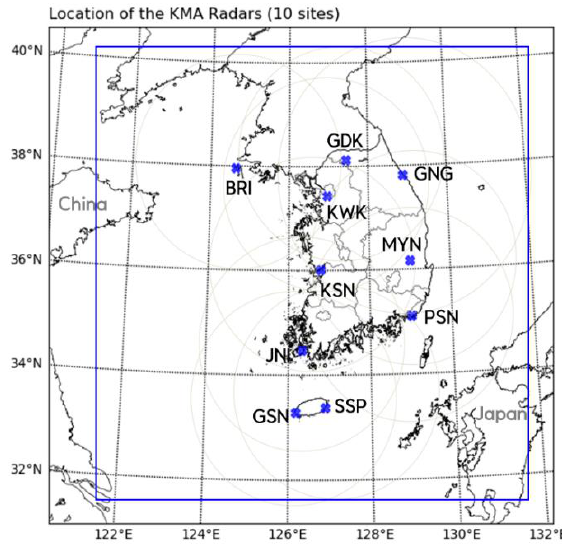
Figure 1. Operational S-band Doppler weather radar network of the KMA. The blue marks and gray circles represent the locations of individual radars and their observational ranges, respectively. The blue box stands for the domain of WISSDOM. Table 1. Characteristics of the KMA’s S-band radar.